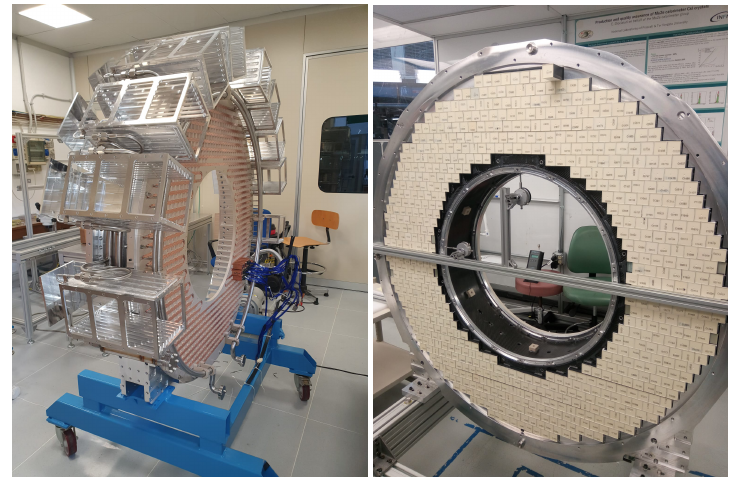
Figure 7. Current status of calorimeter assembly: ( left ), a dry fit of the upstream disk mechanical structure in the LNF clean room; ( right ), the downstream disk with all 674 crystals inserted at Fermilab SIDET clean